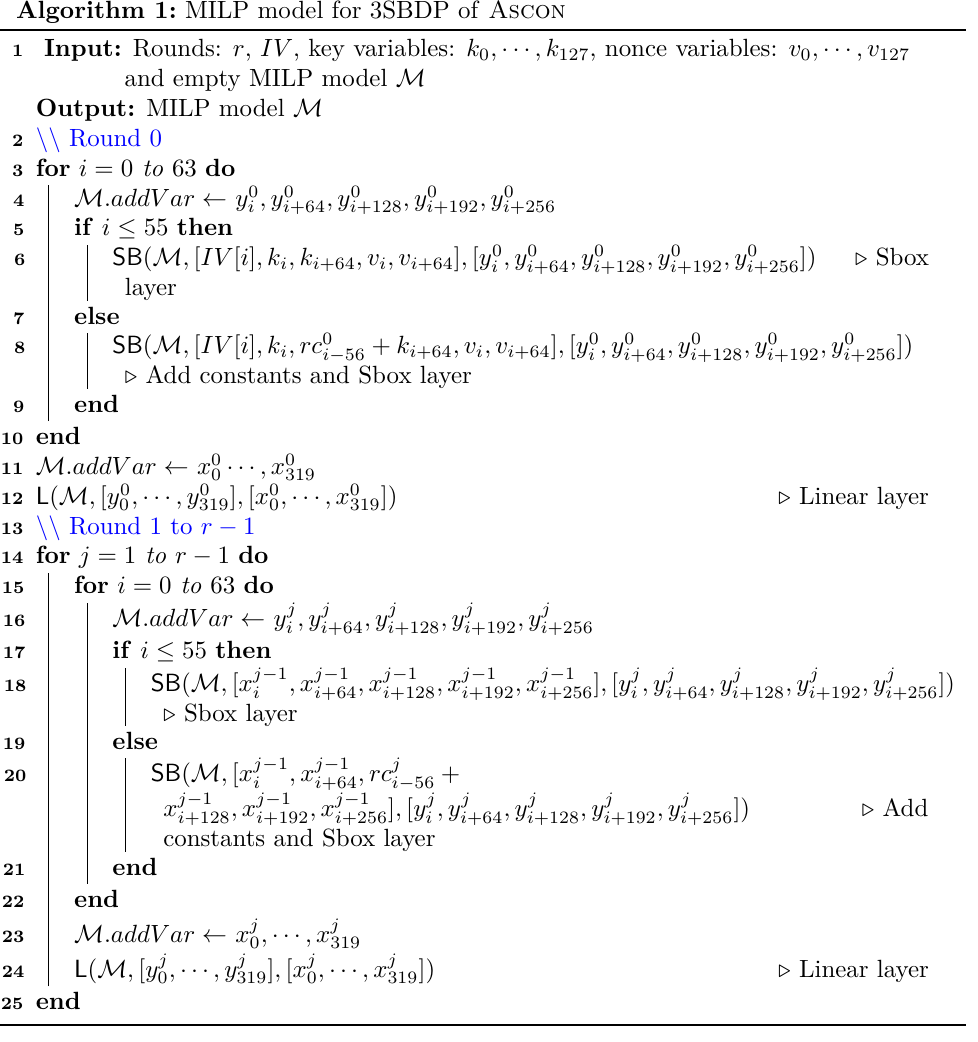
Algorithm 1: MILP model for 3SBDP of